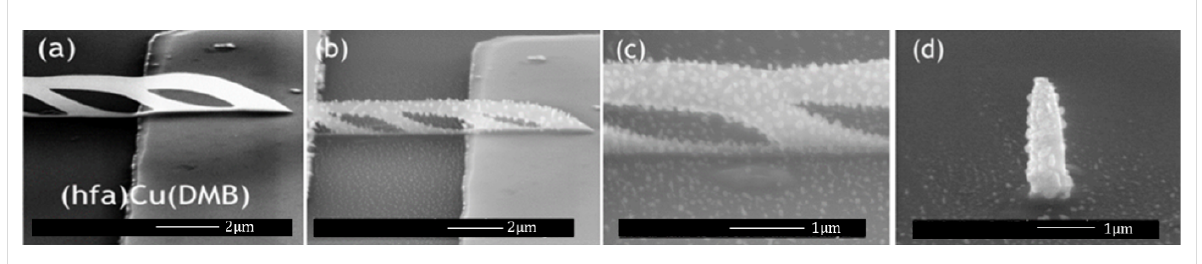
Figure 5: Periodic 3D FEBID line deposits from (hfac)Cu(DMB) between gold electrodes on SiO 2 /Si. SEM tilt images: a) before annealing, b) after in situ vacuum annealing, c) zoom on Cu nanocrystals, d) tip deposit showing also Cu nanocrystal formation.